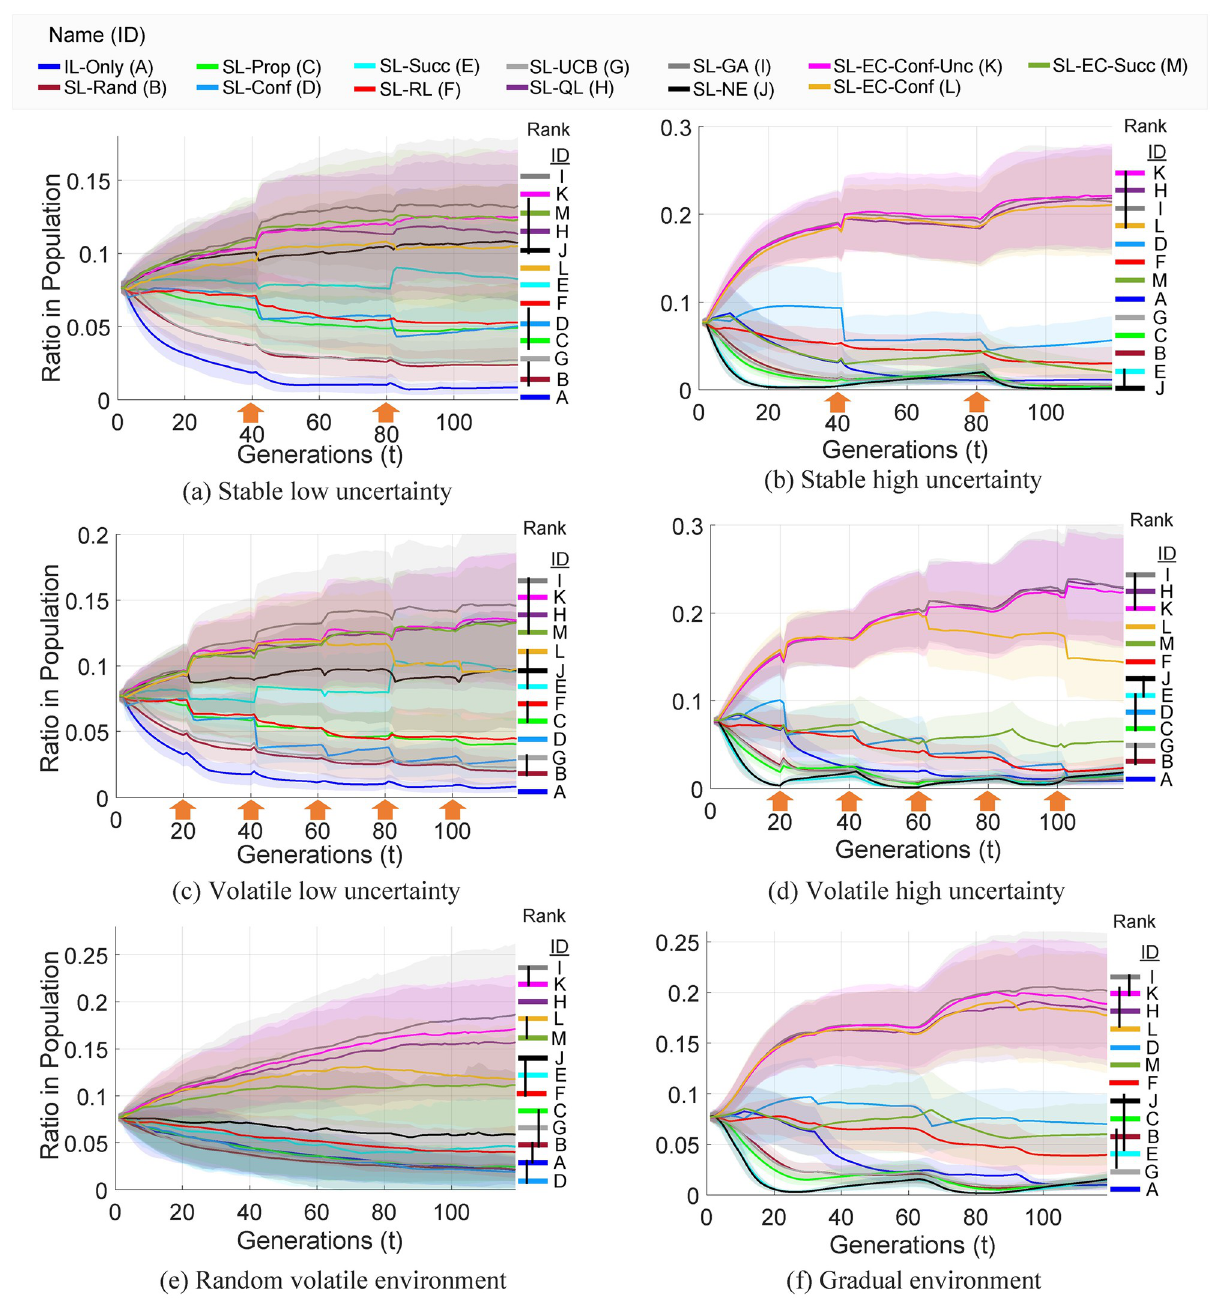
Fig 5. Based on the ratios in the populations, SL-GA, SL-EC-Conf-Unc, SL-QL and SL-EC-Conf are the most dominating meta-social learning strategies in wide range of environments. On the right of each figure, the ranks of the algorithms (higher to lower in terms of ratios) at the end of the processes are shown. The strategies were labeled and color coded to correspond to names provided on top. The differences that are not statistically significant (at p > 0.05, Wilcoxon rank-sum test) are linked by black vertical lines. The points of environment change are indicated with orange arrows. The highlighted areas show the standard deviation 112